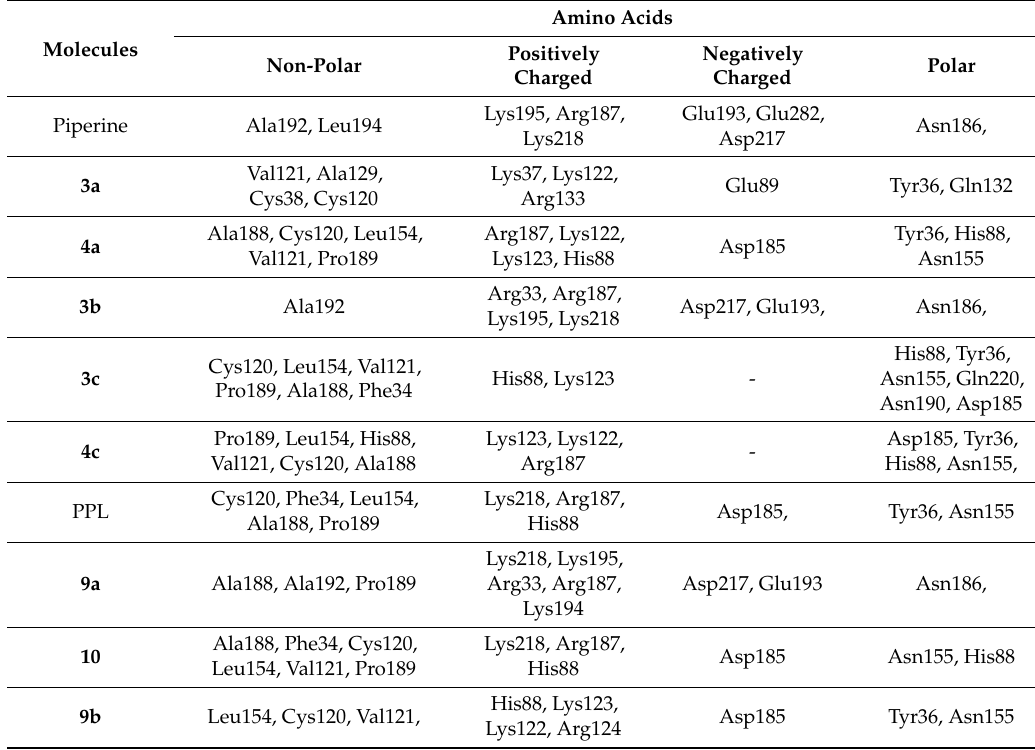
Figure 4. NF- κ B (iceblue) binding environments to ( A ) Piperine and analogues (Piperine-cyan, 3a -orange, 4a -purple, 3b -yellow, 3c -red, 4c -green). ( B ) PPL and analogues (PPL-blue, 9a -pink, 10 -lime, 9b -iceblue). Table 3. Amino acids that compose the microenvironment of the complex NF- κ B / piperine and PPL analogues, obtained by molecular